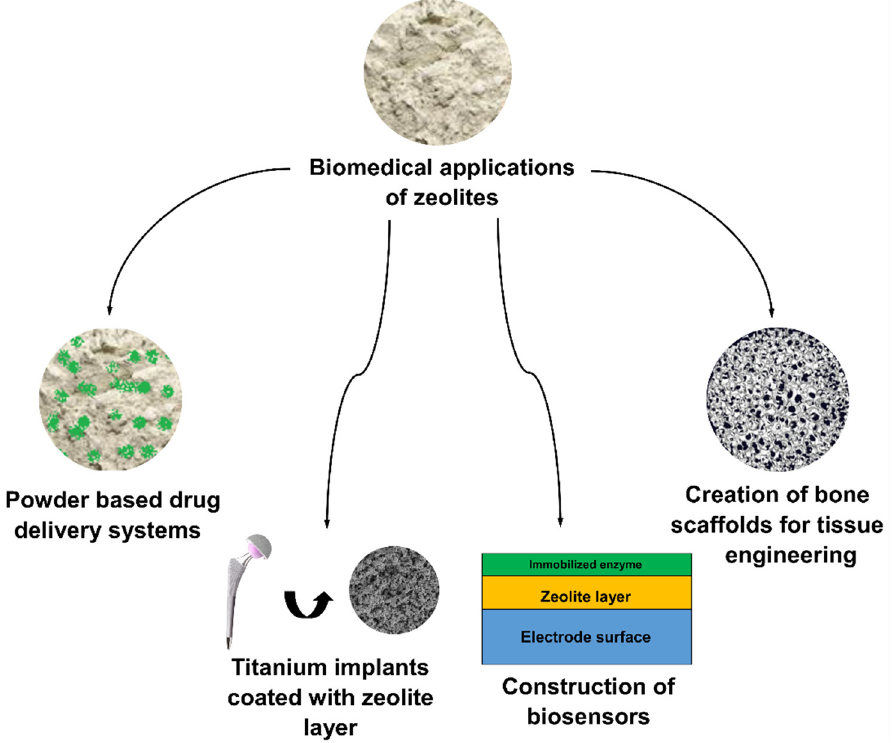
Figure 2. Biomedical applications of zeolites.